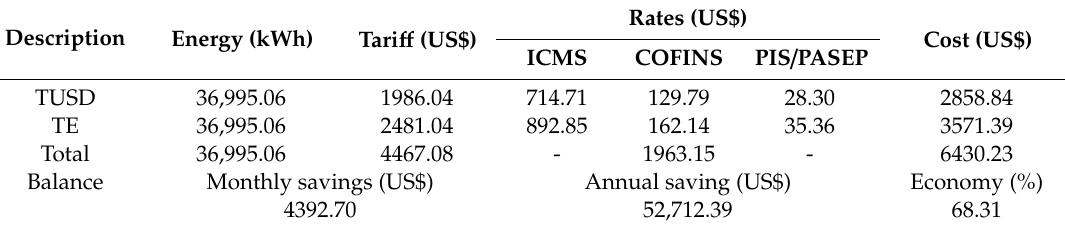
Table 10. Energy costs according to the conventional tari ff for company B.